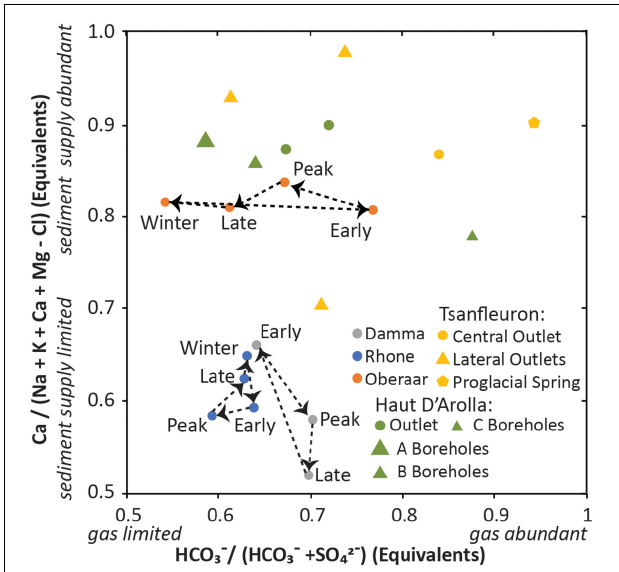
FIGURE 2 | Data from the Alps. Except for Tsanfleuron, data represent multi-sample averages.